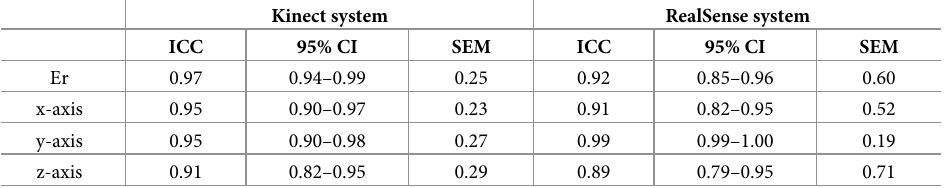
Table 1. The reliability of the assessment of the estimation accuracy using the method proposed in this study for the Kinect system and RealSense